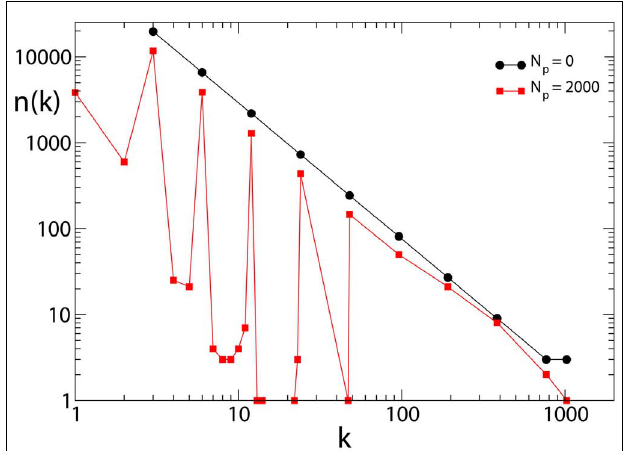
FIGURE 4 | Connectivity degree distribution n ( k out ) at different pruning stages N p forApollonian networks with equal initial synaptic strengths and α = 0.020. As soon as pruning starts to eliminate bonds, new connectivity degrees appear, not present in the original network. Conversely, two out of the three corner sites, which for the generation N = 9 have initially a connectivity degree 1025, may loose bonds because of pruning and, as a result, n (1025) = 1.